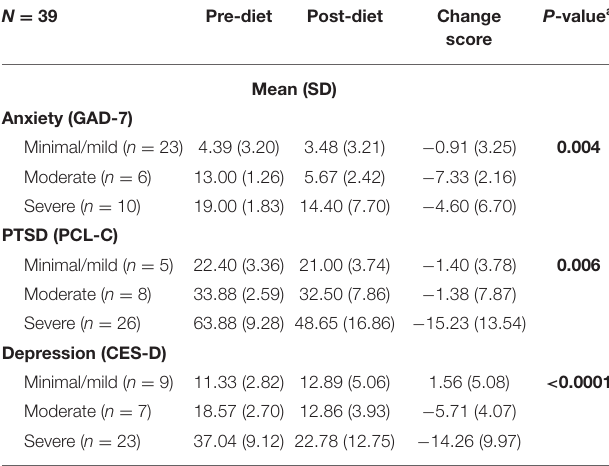
TABLE 2 | Change in psychological symptoms (Post-diet minus Pre-diet baseline scores) between categories after 1-month on the low glutamate diet (ANOVA). N =